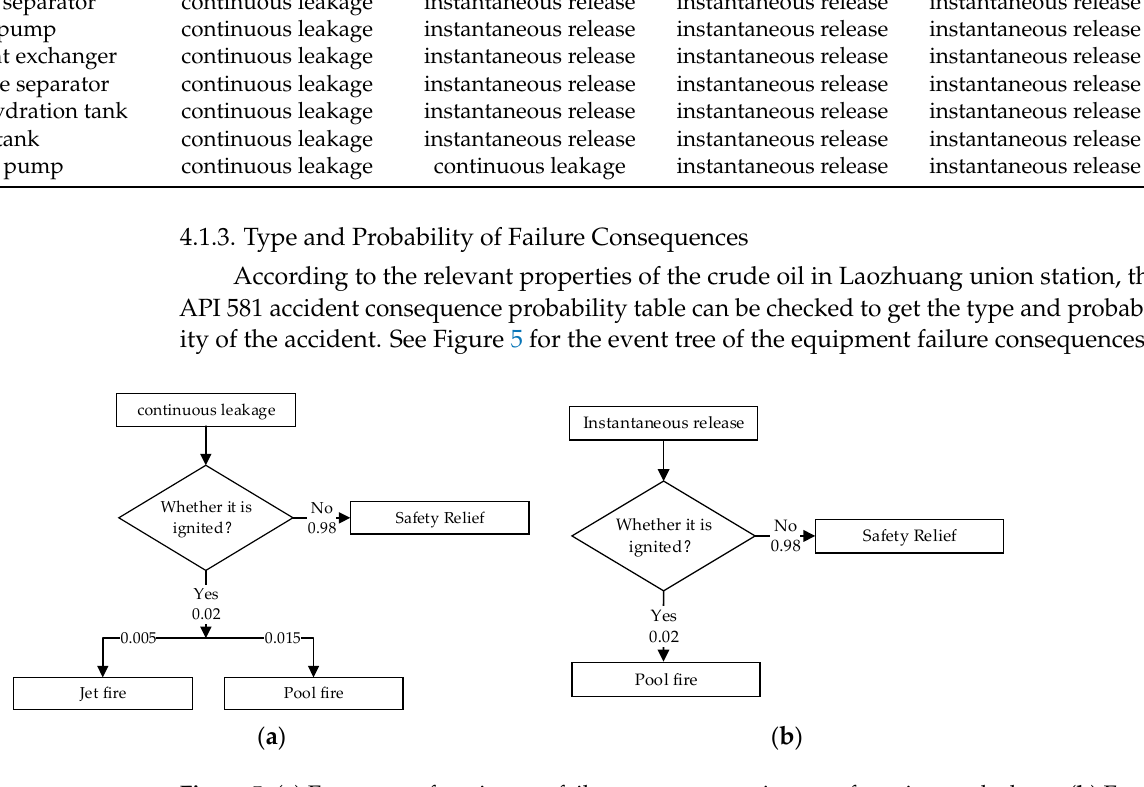
Table 8. Leakage type of equipment under different leakage aperture.